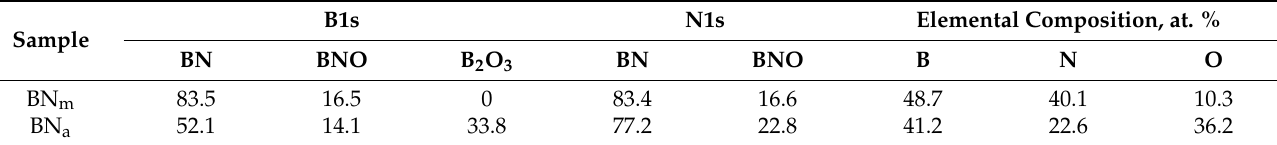
Figure 3. XPS spectra: BN m ( a ) and BN a ( b ) samples. Table 1. Surface chemical state before and after annealing.